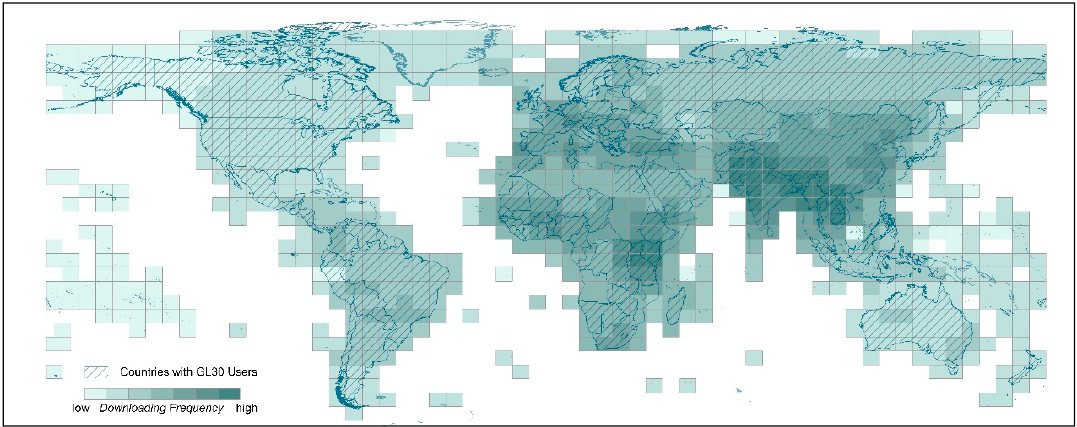
Figure 3. User’s geographical distribution and download frequency of GlobeLand30.